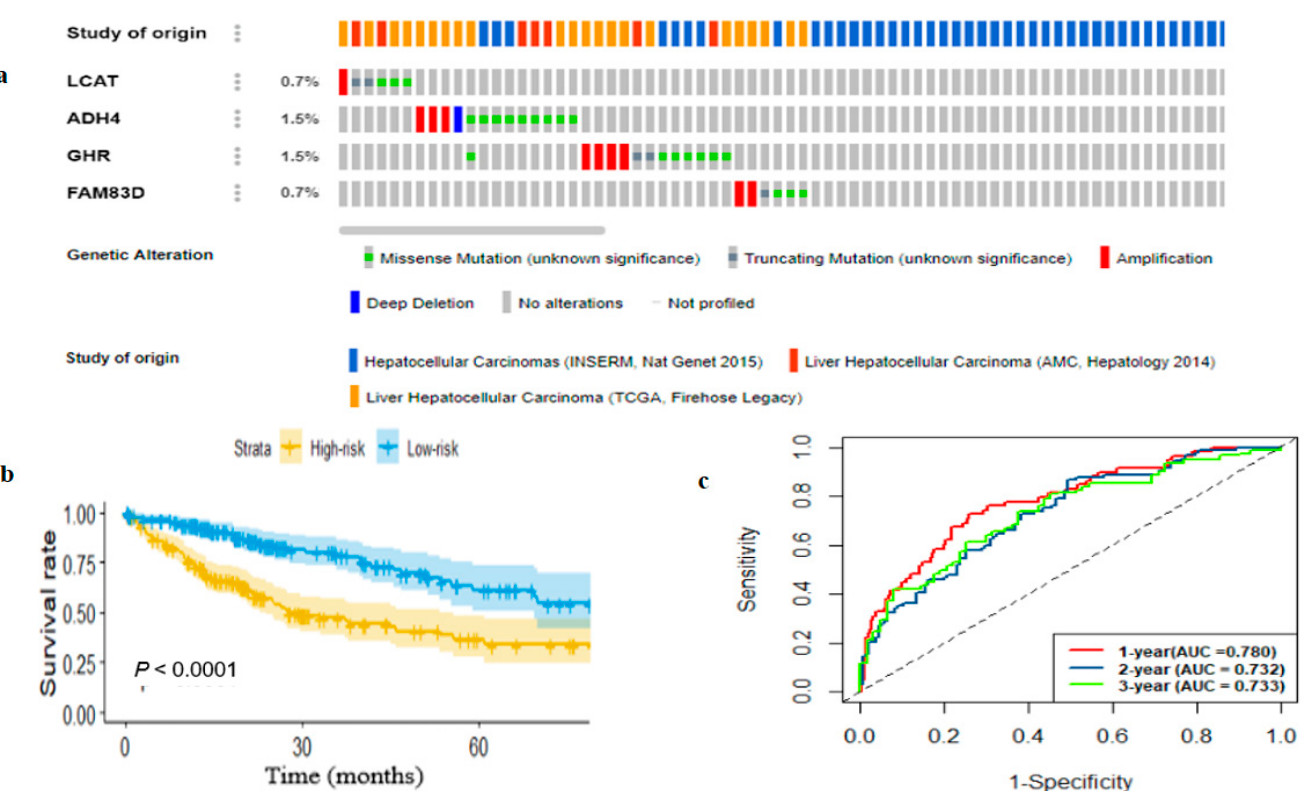
Figure 4. Prognostic assessment of four-gene signature for HCC. The four-gene signature genetic alteration in multiple HCC studies identified by cBioportal ( a ). Kaplan–Meier (KM) survival analysis for high-risk and low-risk subgroups stratified by RS model in TCGA dataset ( b ). Validation of four-gene signature by time-dependent receiver operating characteristic curve (ROC) analysis in TCGA dataset ( c ). RS, risk score .